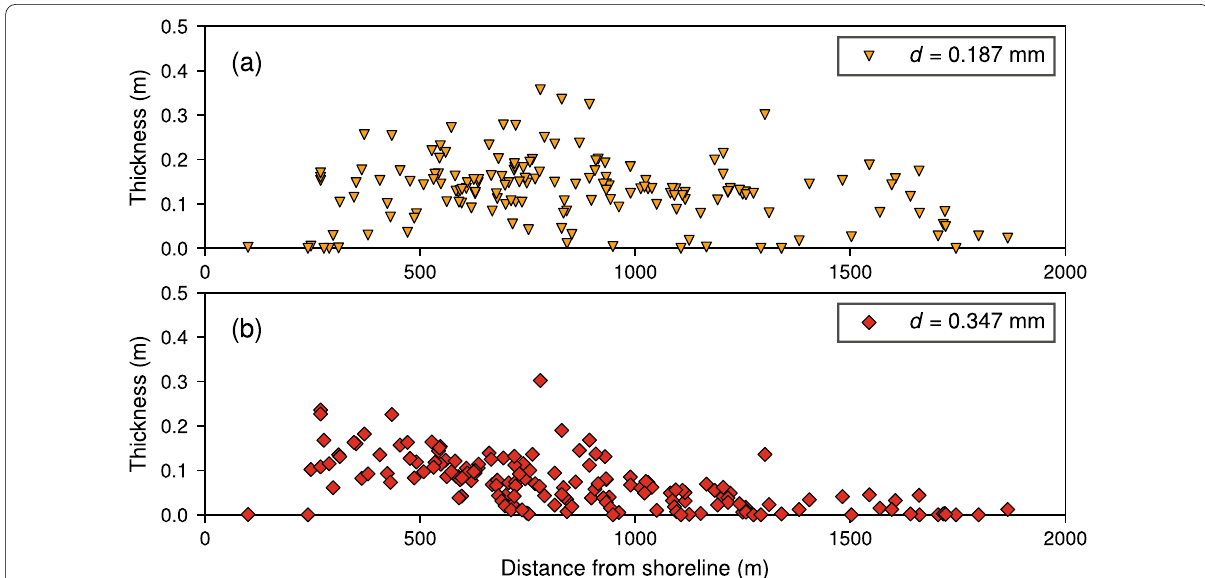
Fig. 6 Grain-size-dependent changes of the shore-normal distribution of simulated tsunami deposits. a Results of the finest ( d = 0.187 mm) and b coarsest grain size ( d = 0.347 mm)